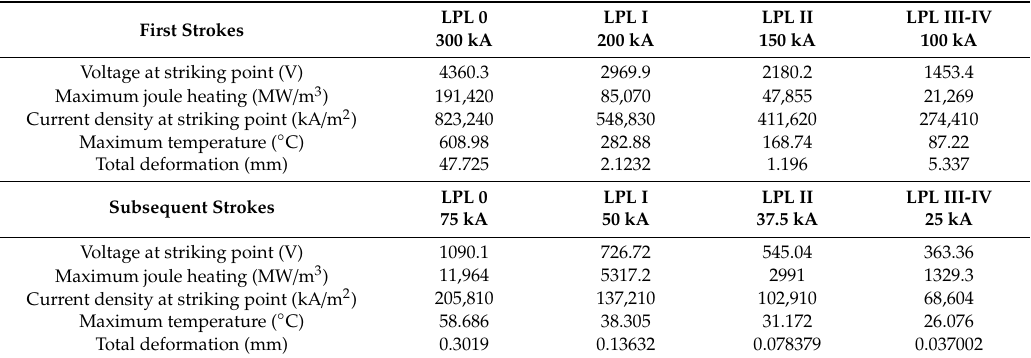
Table 2. Results obtained from the first and subsequent return strokes for Case Study A.